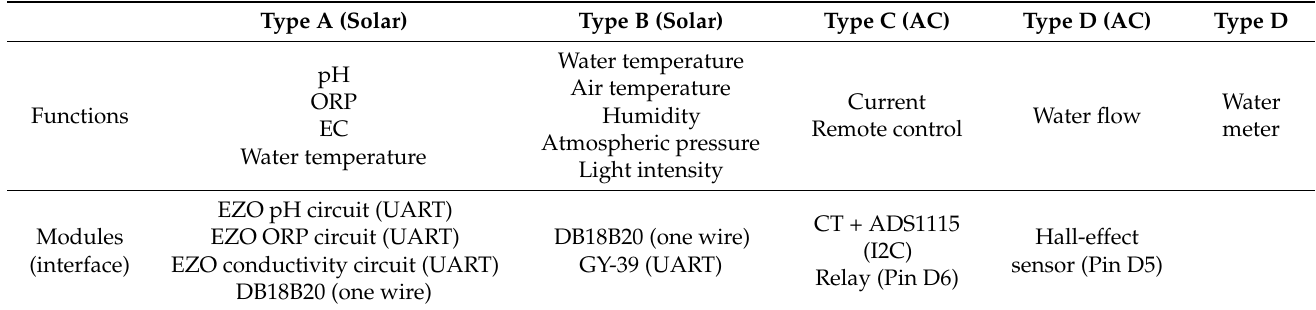
Table 1. Four types of IoT